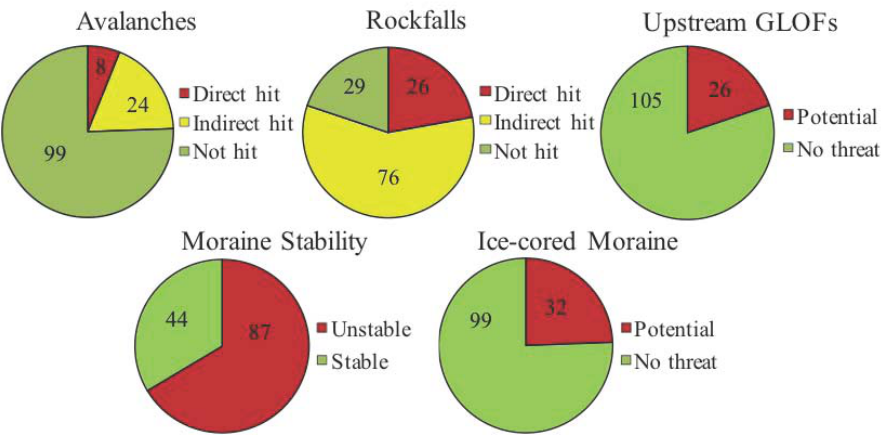
Figure 4. Breakdown of hazard parameters that threaten the glacial lakes.